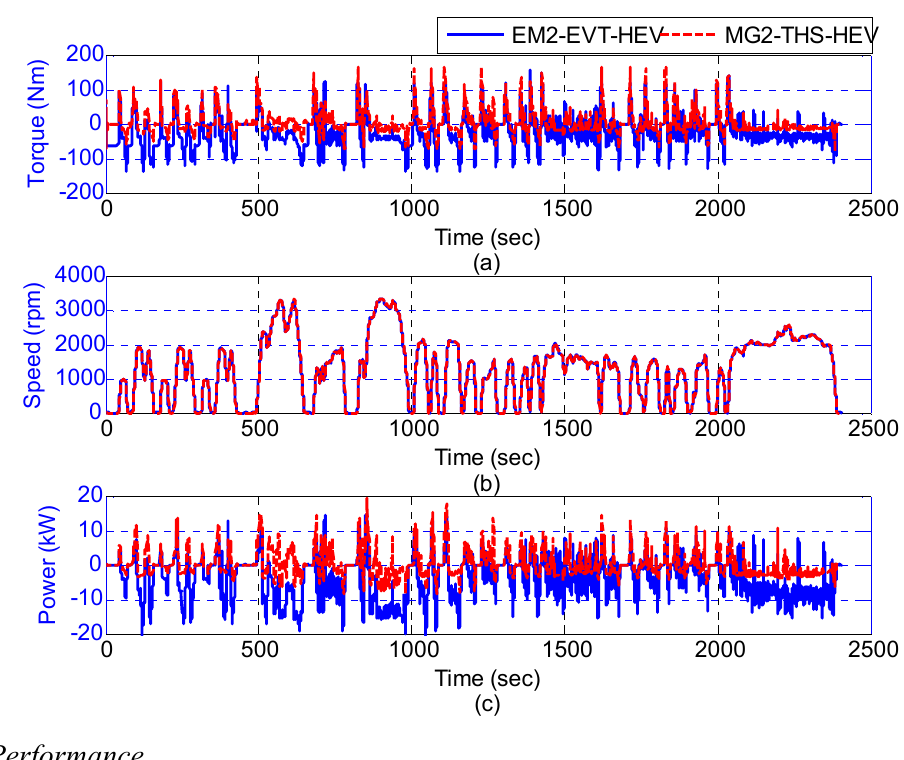
Figure 19. EM2/MG2 Performances of EVT-HEV and Prius HEV: ( a ) torque; ( b ) Speed; ( c ) Power.